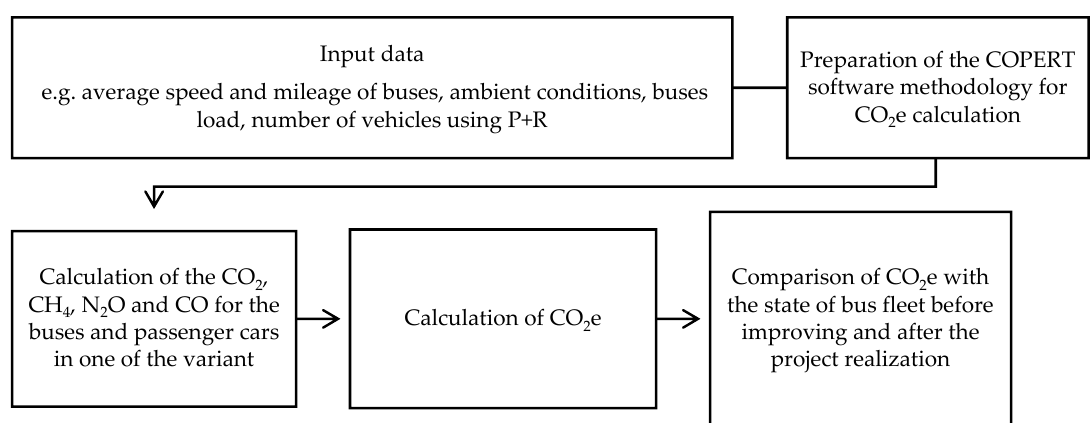
Figure 1. General scheme showing the procedure for the proposal of CO 2 e calculation methodology for buses.